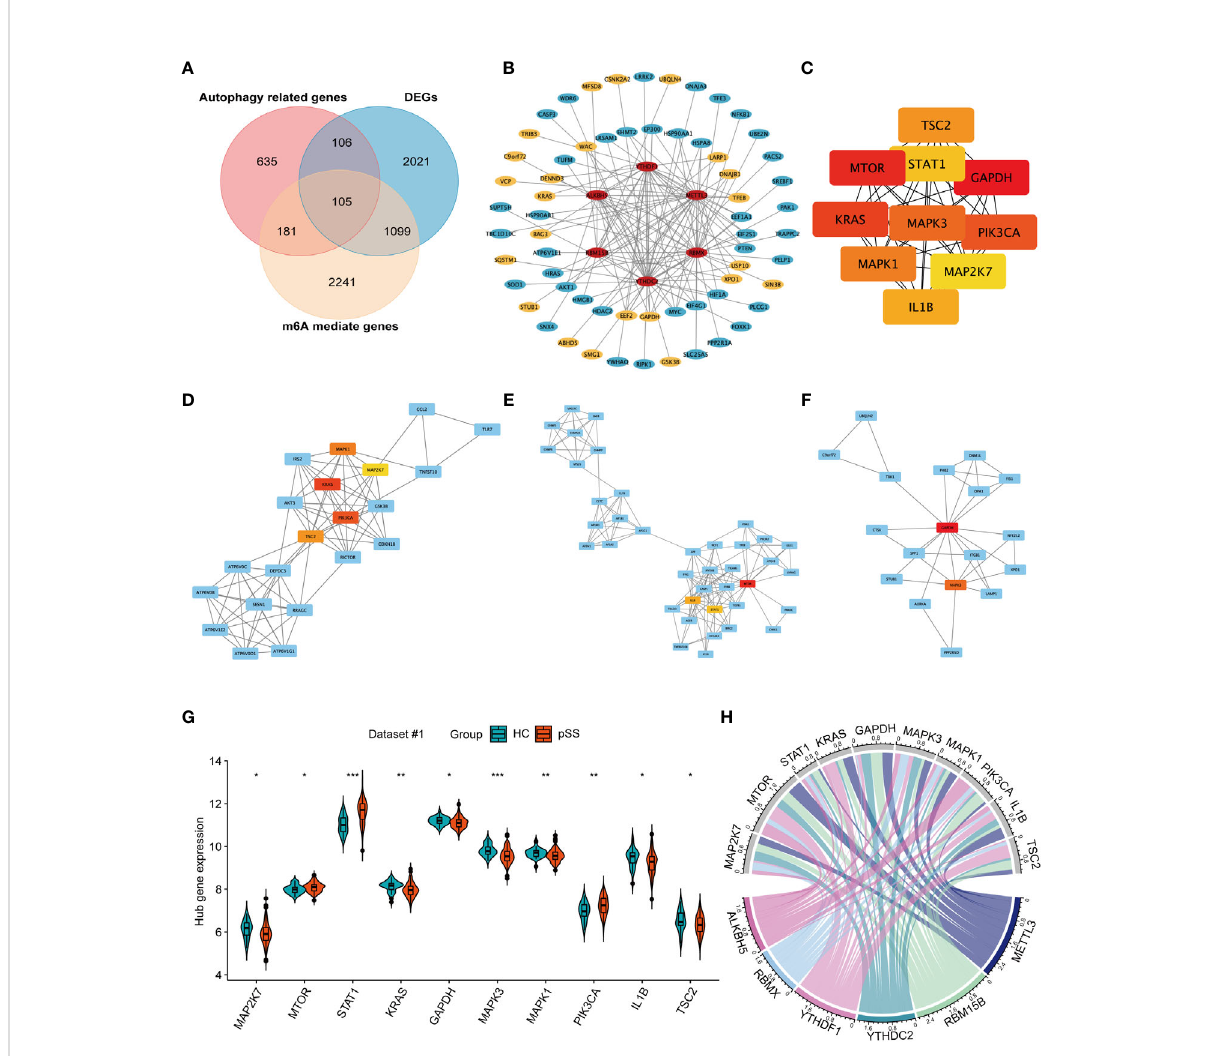
FIGURE 6 The network for autophagy-related genes modi fi ed by key pSS-related m6A regulators. (A) The venn plot illustrates the intersection of m6A mediated genes, autophagy-related genes, and the differentially expressed genes in pSS. (B) Protein-protein interaction (PPI) network among the pSS-related DEMRs and autophagy-related genes mediated by m6A regulators (n=286). Red represents m6A regulators, blue represents autophagy-related genes, among which the signi fi cantly expressed genes in pSS compared with HCs are highlighted in yellow. (C) The top 10 candidate hub genes of the differentially expressed autophagy-related genes (n=211) ranked by the maximum clique centrality (MCC) method. (D-F) . The top 3 subnetwork gene clusters were exported using the MCODE program. The hub genes were highlighted in red or yellow color as in Figure 6C. (G) The violin plot illustrates the autophagy hub genes that are dysregulated between the HCs and pSS groups in dataset #1. (H) The chord diagram demonstrated the correlation between DEMRs and autophagy hub genes. *, p<0.05; **, p<0.01; ***,